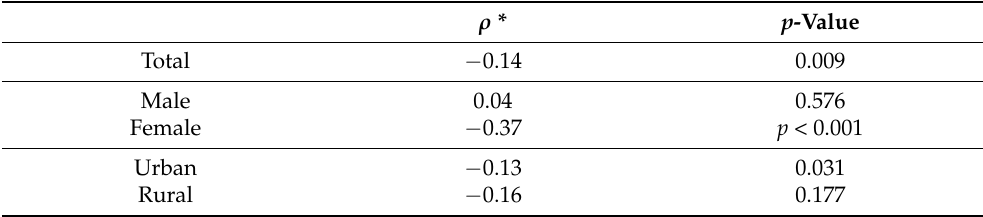
Table 3. Correlation between Physical functioning score and age by gender and household type. ρ * p -Value Total − 0.14 0.009 Male 0.04 0.576 Female − 0.37 p < 0.001 Urban − 0.13 0.031 Rural − 0.16 0.177 * Spearman’s rank correlation coefficient.